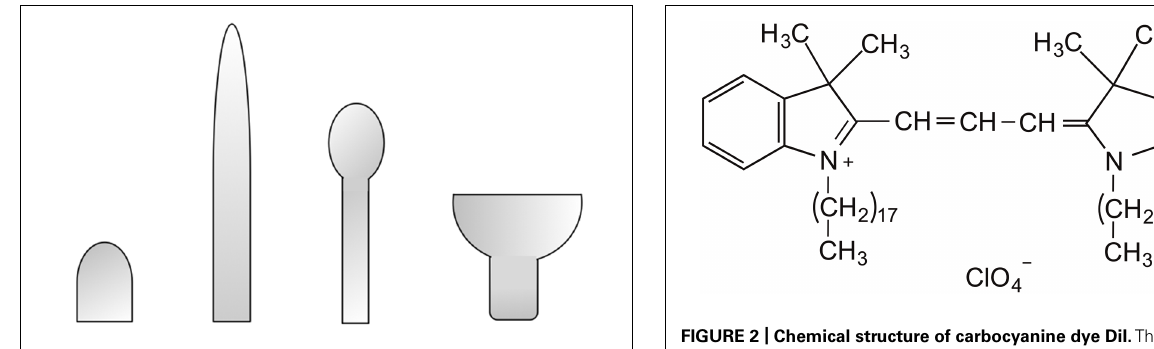
FIGURE 2 | Chemical structure of carbocyanine dye DiI. The fluorescent lipophilic dye “DiI” [1,1 (cid:2) -dioctadecyl-3,3,3 (cid:2) ,3 (cid:2) tetramethylindocarbocyanine perchlorate; DiIC18(3)] is commonly used as an anterograde and retrograde neuronal tracer. DiI labels cell membranes by inserting its two long (C 18 carbon) hydrocarbon chains into the lipid